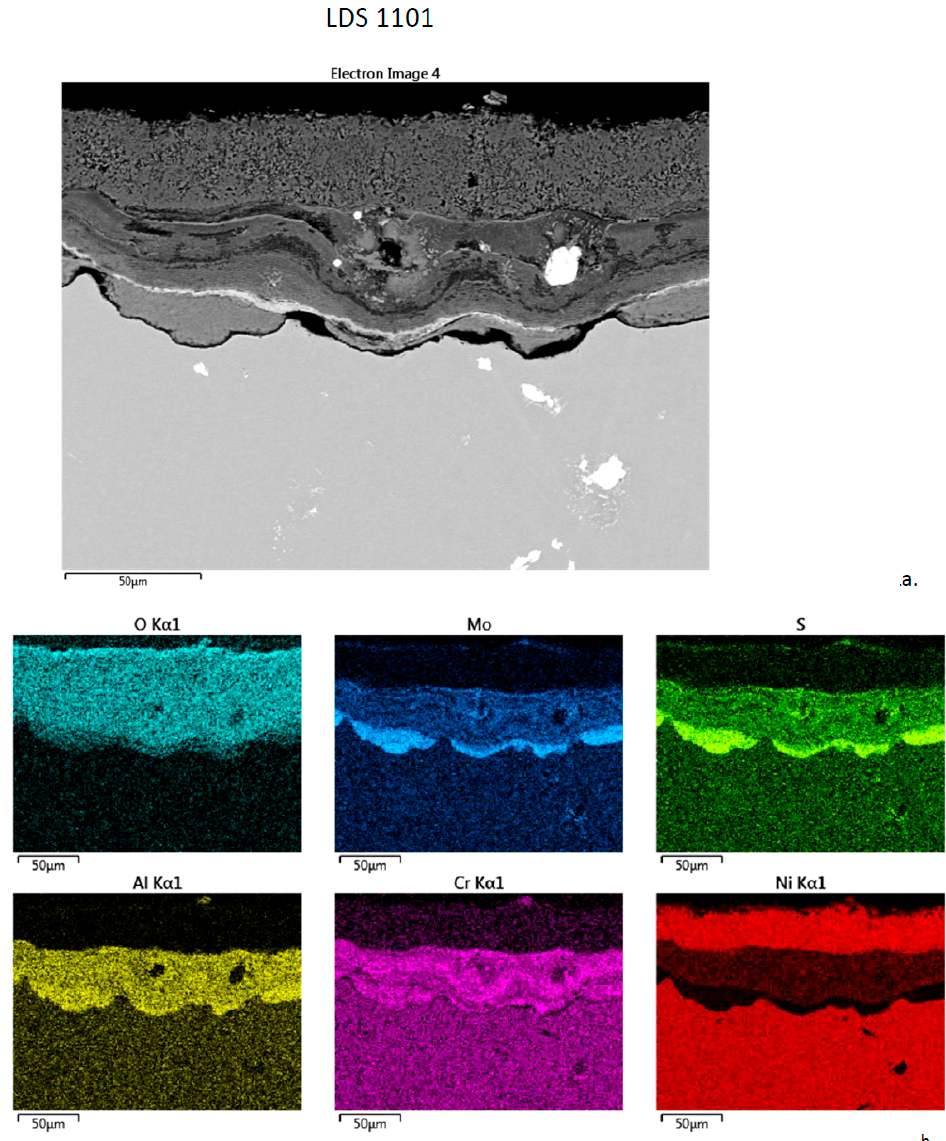
Figure 11. Cross-section of LDS 1101 sample after 300 h LTHC at 700 °C. ( a ) SE image showing complex corrosion layers and internal carbides. ( b ) Elemental rasters for O, Mo, S, Cr, Al, Ni showing inner Al, Cr-S cusps, intermediate Al, Cr-O band, and outer Ni band. The same is true for the (F) LDS 1011 (5Cr-0Co-12Mo-3Re) alloy, as shown in Figure 12. Here the distinct boundary between the 50 + 50 μ m inner/outer layers appears to be that of the original alloy surface. The Al-Cr-O-S inner layer is again highly delineated. S appears to be penetrating a long crack or bright carbide/boride boundary within the alloy.